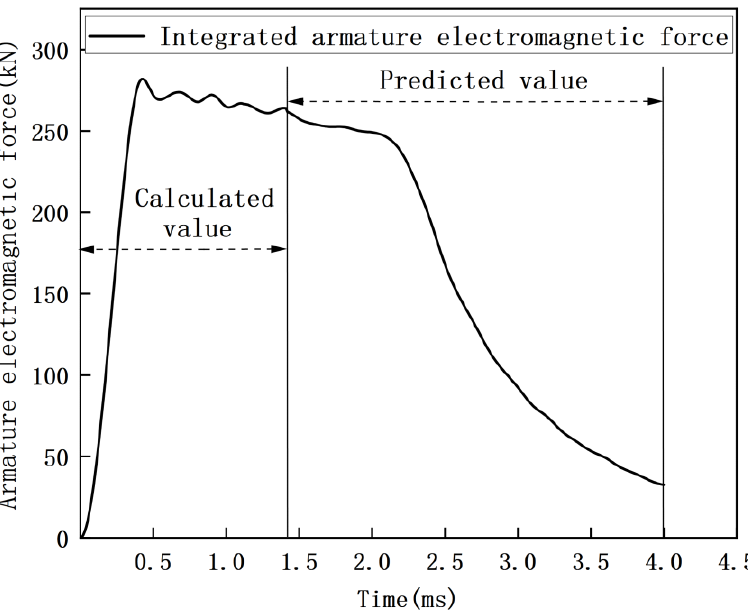
Figure 17. Integrated armature electromagnetic force under standard armature conductivity in case